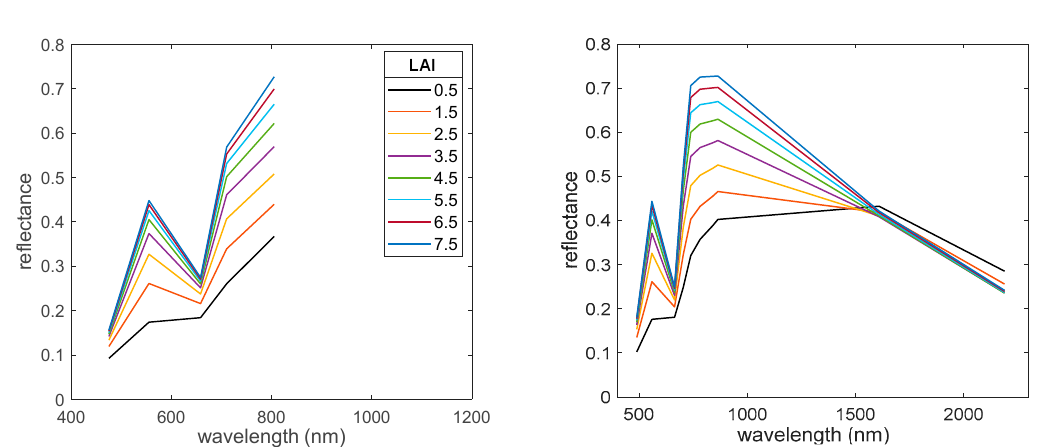
Figure 4. Sensitivity analysis highlighting the effect of variation of leaf area index (LAI) on simulated canopy reflectance of RapidEye and Sentinel-2 using PROSAIL. Reflectance values are at distinct spectral wavelengths; lines are used to help the interpretation.